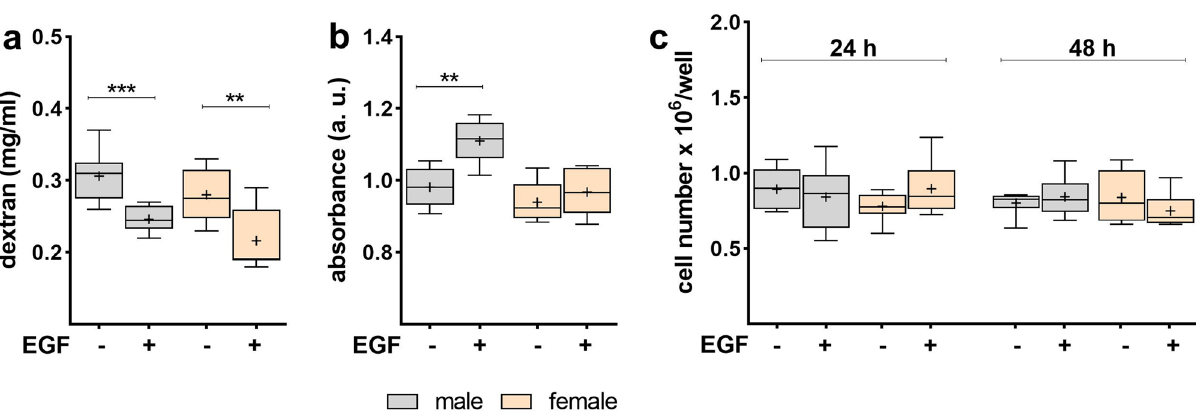
Figure 7. EGF decreased permeability in both sexes, but increased metabolic activity only in males. FDLE cells were cultured in SF-Med and stimulated with EGF for 24 h. Data are displayed as box and whiskers with the 10–90 percentile, mean (+) and median (horizontal line). ( a ) FITC-dextran assay demonstrated a significantly reduced permeability induced by EGF in male and female FDLE cells (n = 8; ** p < 0.01; *** p < 0.001 by t -test). ( b ) EGF further increased the metabolic activity in male FDLE cells, in contrast to female cells, as shown with a MTT assay (n = 6; ** p < 0.01 by t -test). ( c ) The cell number was not altered by EGF addition in male and female FDLE cells after 24 and 48 h (n = 6–8). (Grey boxes) male; (yellow boxes)